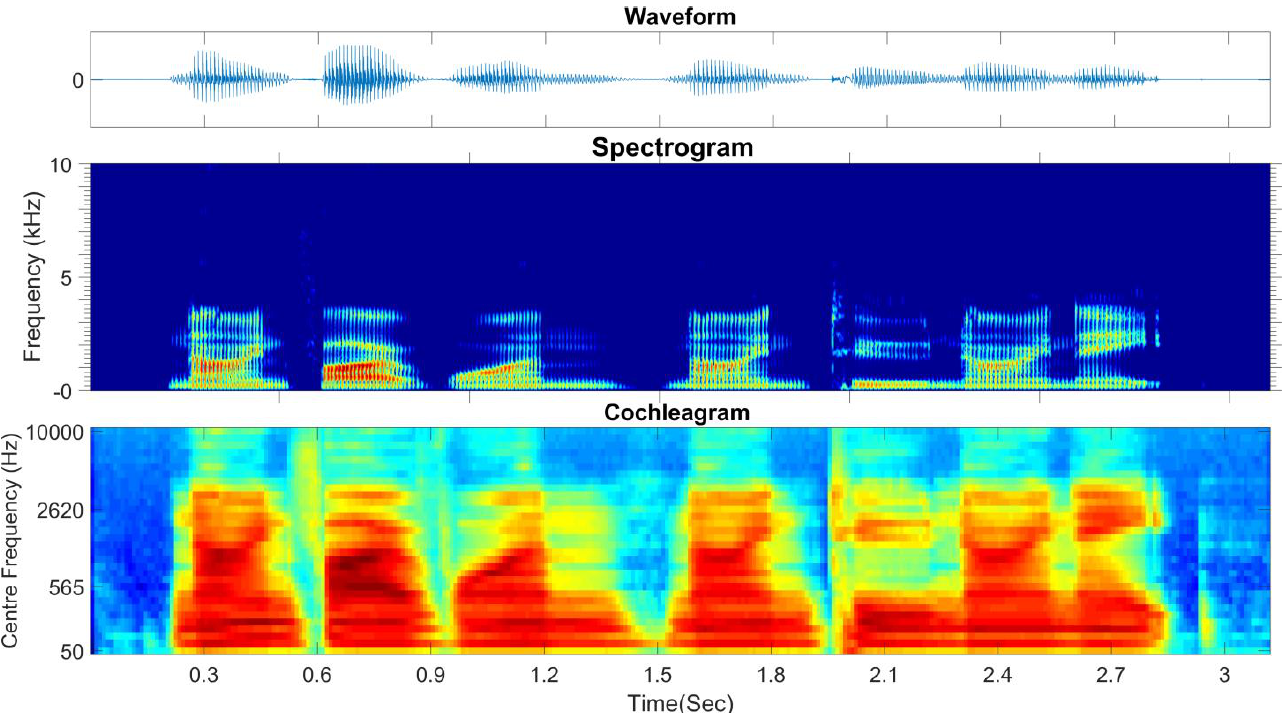
Figure 7. The spectrogram and cochleagram of a sample speech signal from TIDIGITS database.